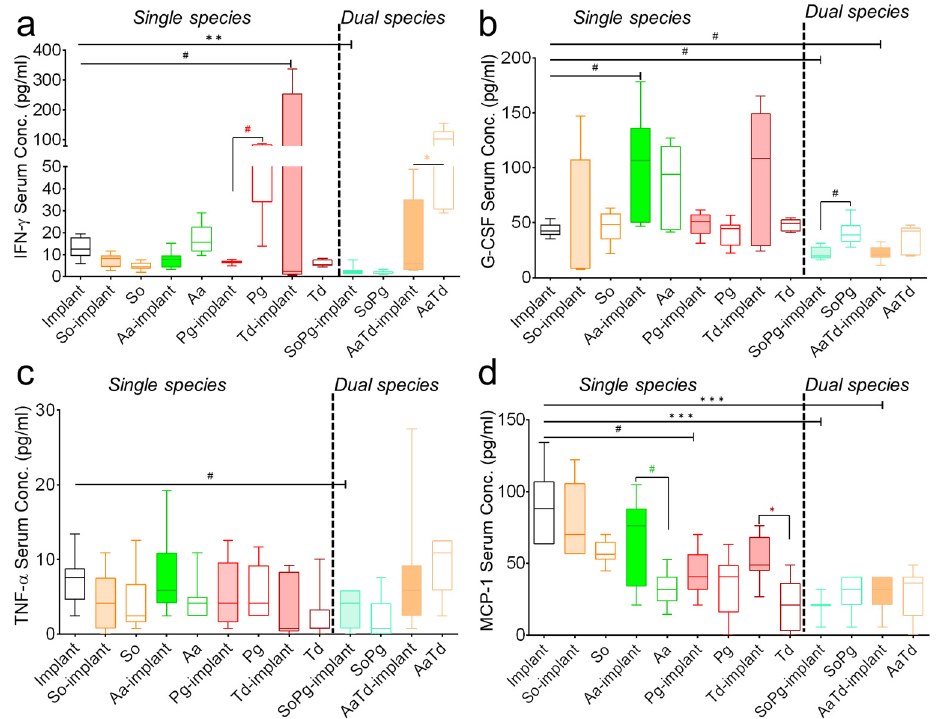
Figure 5. Systemic levels of inflammatory cytokines. Graphs show serum levels of IFN- γ ( a ), G-CSF ( b ), TNF- α ( c ), and CCL2/MCP-1 ( d ) 21 days after implantations and infections. Empty bars represent sterile implants, colored bars indicate infected implants, and empty bars with colored borders indicate infected tissues. Data from three independent experiments are shown. Data were analyzed animal-wise (biological replicates ( n = 3), technical replicates (3 each)). Significant values were adjusted by the Bonferroni correction for multiple tests. Symbols ***, **, *, and # indicate p < 0.001, p < 0.01, p < 0.05, and significant p -value prior to Bonferroni correction, respectively. Black symbols represent significant differences between sterile and infected implants. Colored symbols indicate significant differences between infected implants and infected tissues in the absence of implants. Abbreviation: So ( S. oralis ), Aa ( A. actinomycetemcomitans ), Pg ( P. gingivalis ), Td ( T. denticola ).